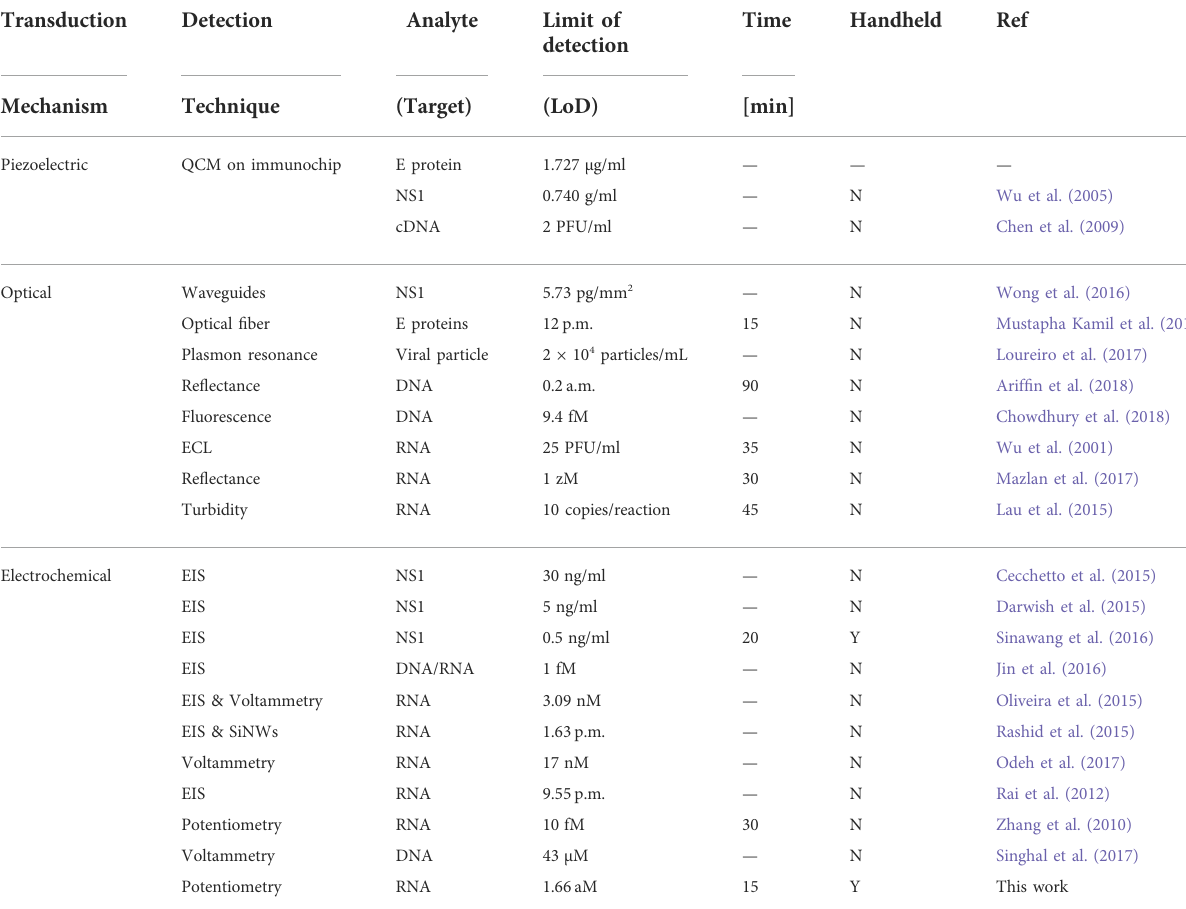
TABLE 3 Comparison of dengue detection tests reported in the literature (Darwish et al., 2018). Transduction